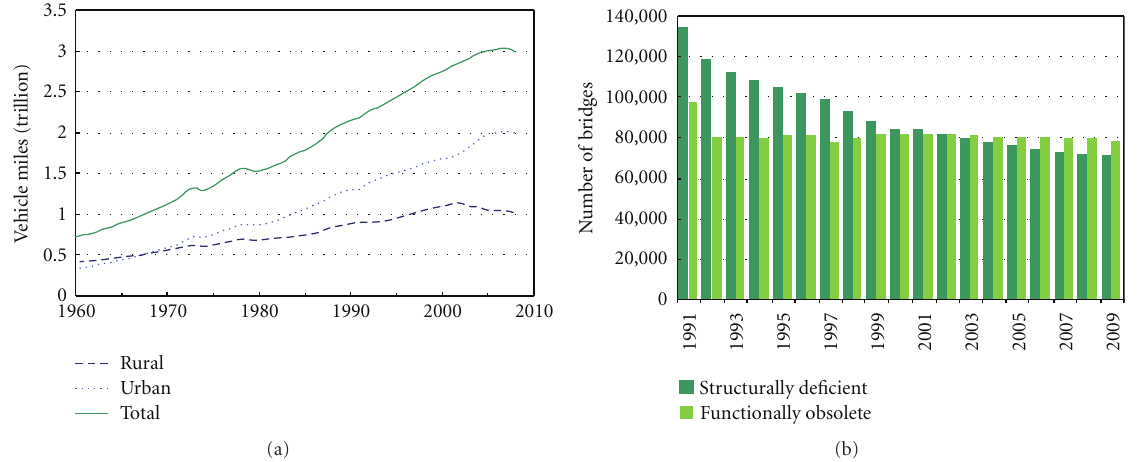
Figure 1: Variation of vehicle miles of travel on US highways (a) and (b) number of structurally deficient and functionally obsolete bridges in the US [1, 2].